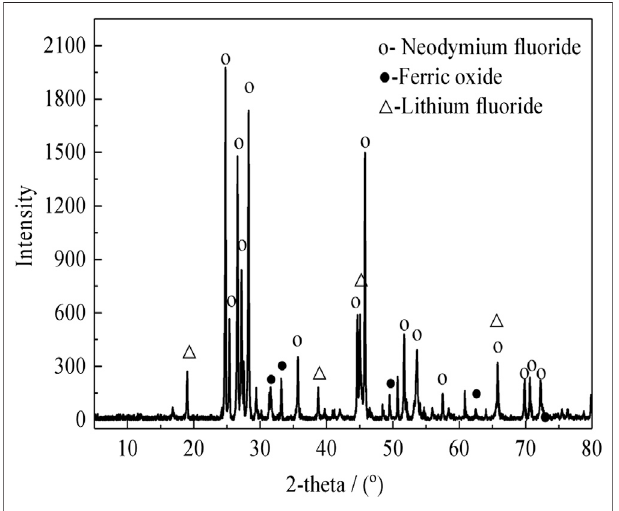
FIGURE 2 | XRD analysis of non-magnetic fraction.